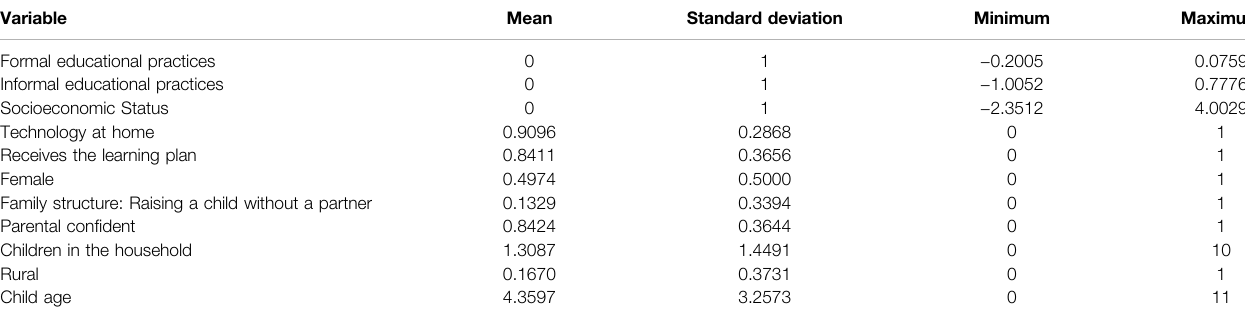
TABLE 2 | Descriptive statistics for all countries. Variable